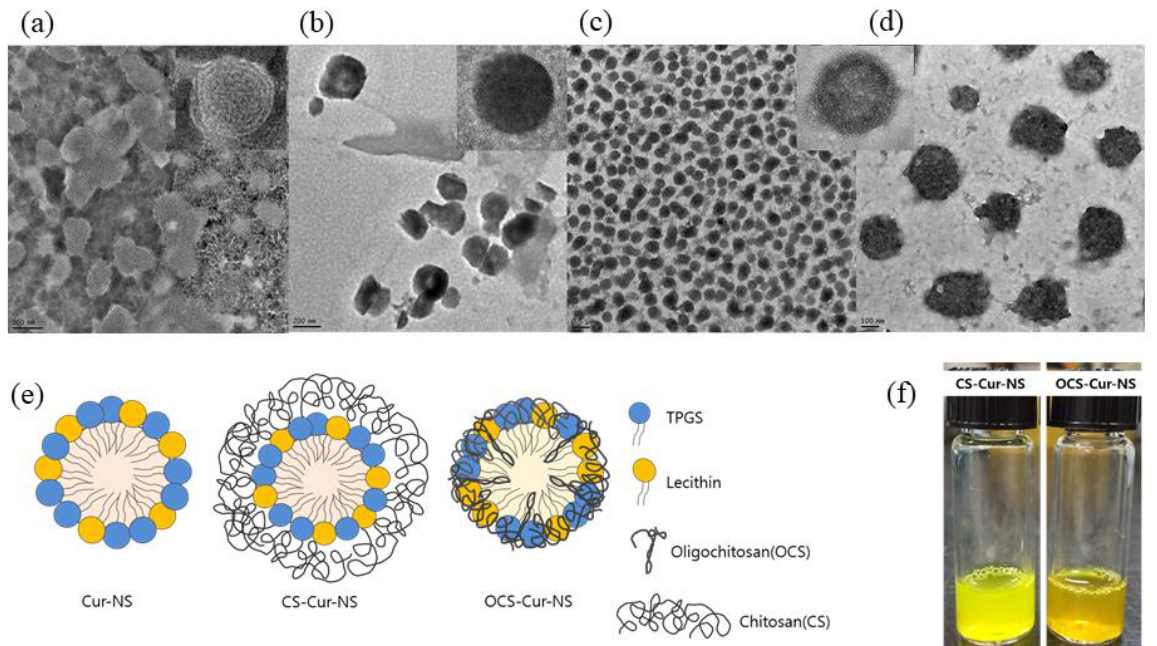
Figure 2. Transmission electron microscopy images of Cur-NSs ( a ), CS-Cur-NSs ( b ), OCS-Cur-NSs with scale bar of 0.5 µ m ( c ) and OCS-Cur-NSs with scale bar of 100 nm ( d ). Schematic representations of Cur-NSs, CS-Cur-NSs, and OCS-Cur-NSs ( e ) and photographical images of CS-Cur-NSs and OCS-Cur-NSs ( f ).